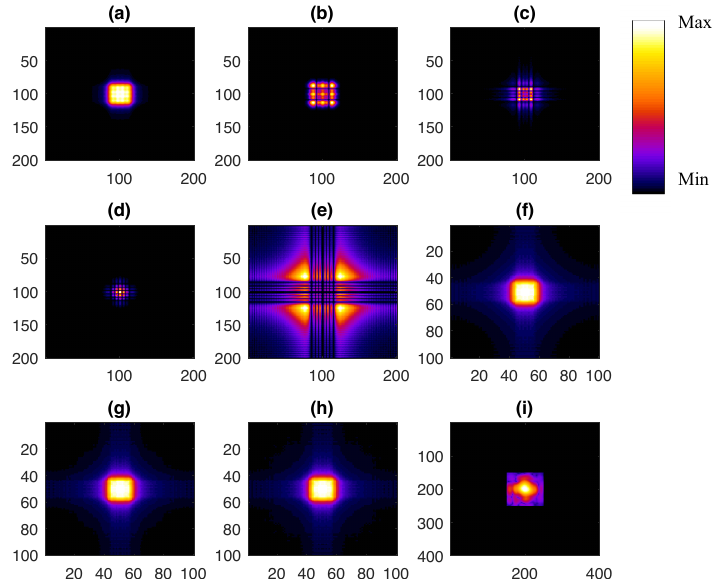
Figure 6. Five first fundamental modes ( a – e ) from SVD of a real-only probe propagated after a pinhole; ( f – h ): simulated sum of 5 modes; 10 modes and 20 modes; ( i ) reconstructed sum of 5 modes of probe. Images are plotted with a fire-style colormap with an arbitrary maximum value. The Figure 6i is reconstructed results of Figure 6f. The minima and maxima of colormap legend bar for Figure 6a–i are as follows respectively: [0, 1.1531]; [0, 0.2707]; [0, 0.3694]; [0, 0.3410]; [0, 0.3273]; [0.0381, 3.1813]; [0.0820,